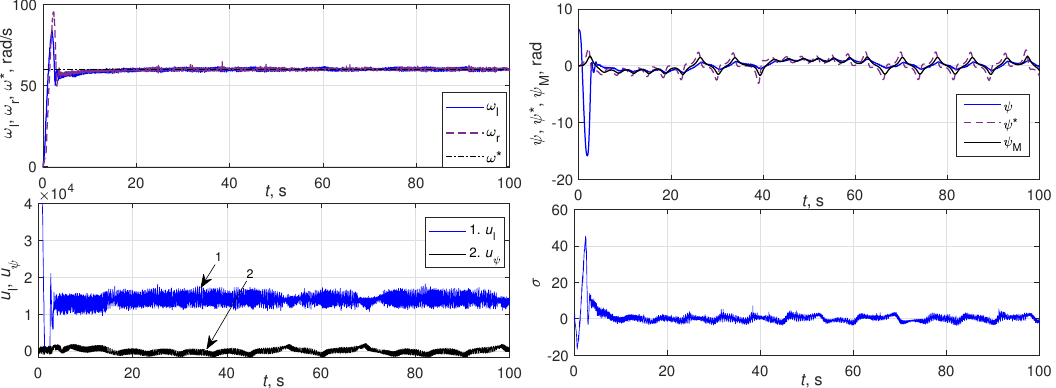
Figure 12. Experiment. Left column: ω l ( t ) , ω r ( t ) , ω ∗ ( t ) ( upper plot ) and control actions u l ( t ) , u ψ ( t ) ( lower plot ) time histories; right column: ψ ( t ) , ψ ∗ ( t ) , ψ M ( t ) ( upper plot ) and IMR discrepancy signal σ ( t ) ( lower plot ) time histories for chaotic ψ ∗ ( t ) (51), m t = 0.1, c = 0.125.